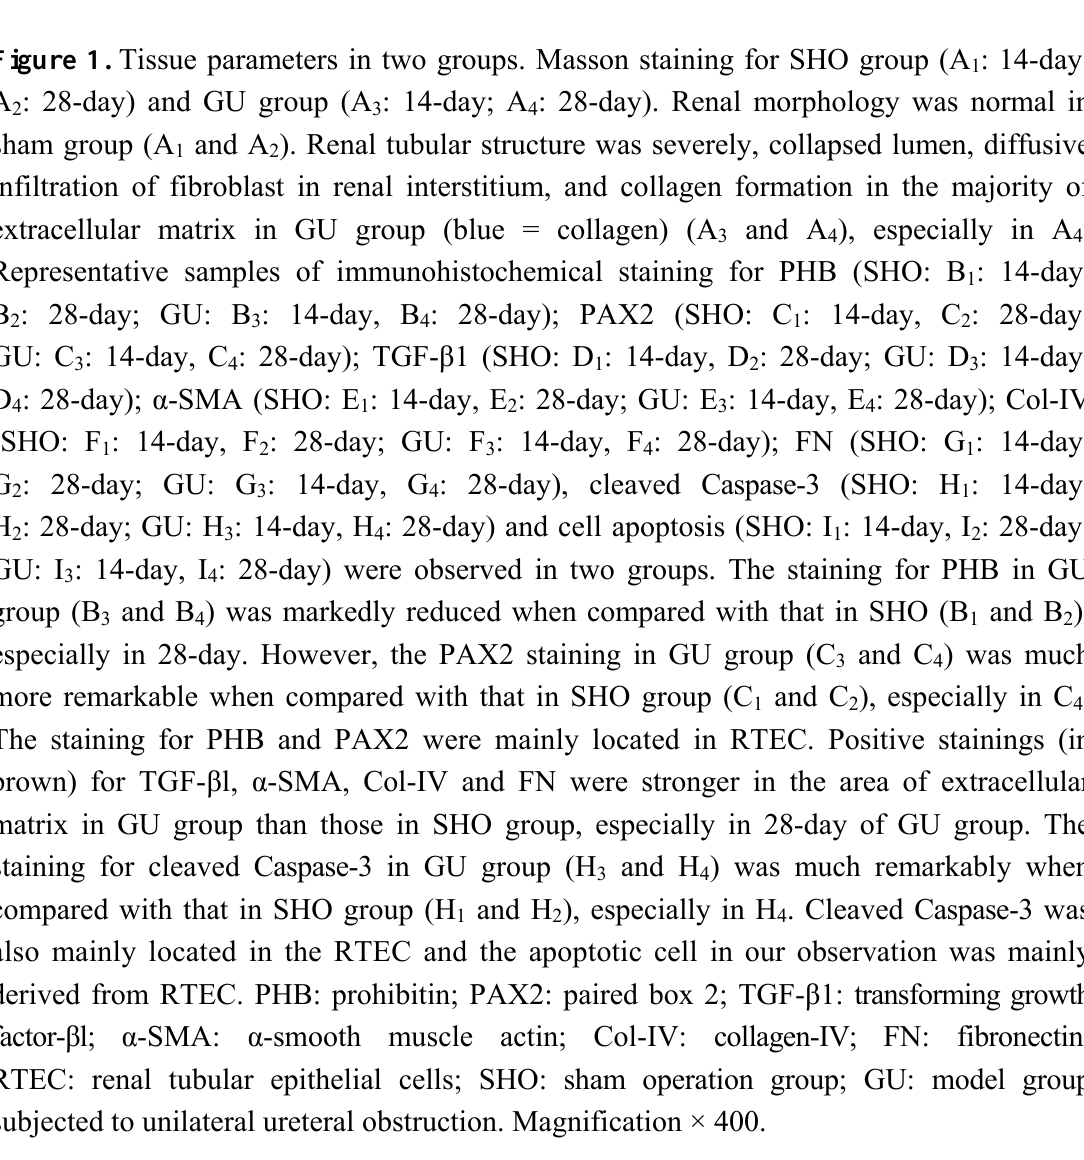
: 14-day; Figure 1. Tissue parameters in two groups. Masson staining for SHO group (A 1 A : 28-day) and GU group (A : 14-day; A : 28-day). Renal morphology was normal in 2 3 4 sham group (A and A ). Renal tubular structure was severely, collapsed lumen, diffusive 1 2 infiltration of fibroblast in renal interstitium, and collagen formation in the majority of extracellular matrix in GU group (blue = collagen) (A and A ), especially in A . 3 4 4 Representative samples of immunohistochemical staining for PHB (SHO: B : 1